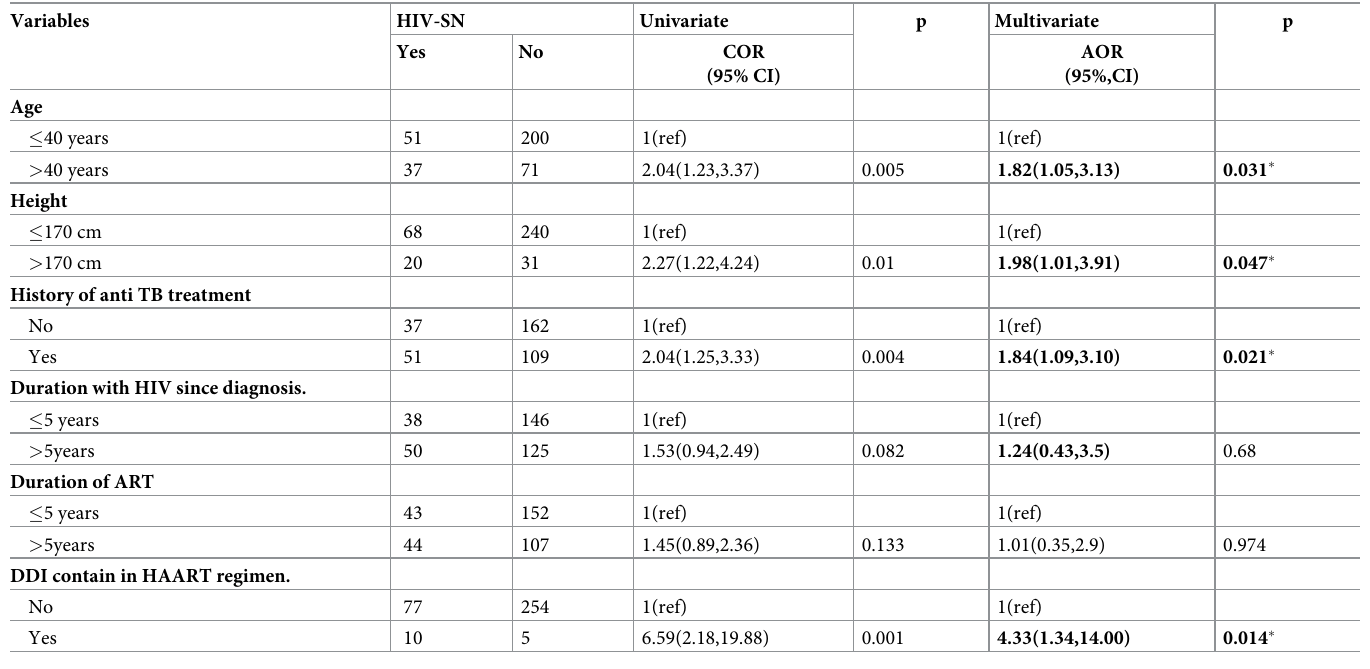
Table 4. Univariate and multivariate analysis for the associated and predicting demographic and health status characteristics to HIV-SN, 2017,